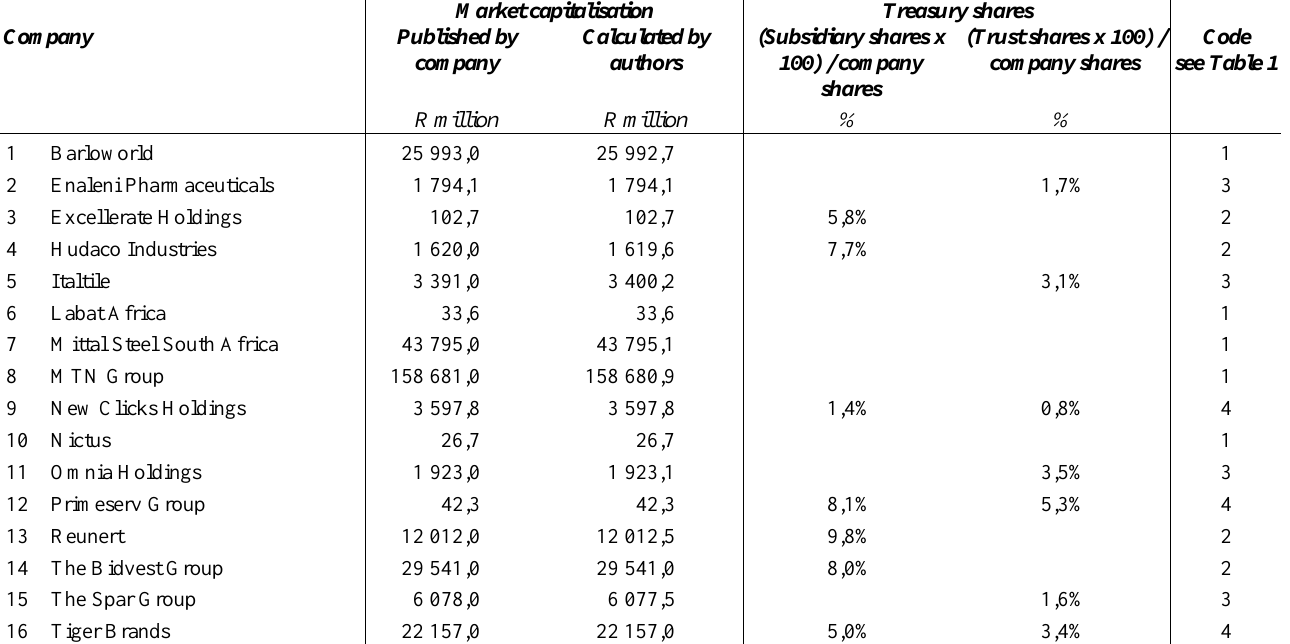
Table 2. Companies publishing market capitalisation based on number of group shares in 2006 annual